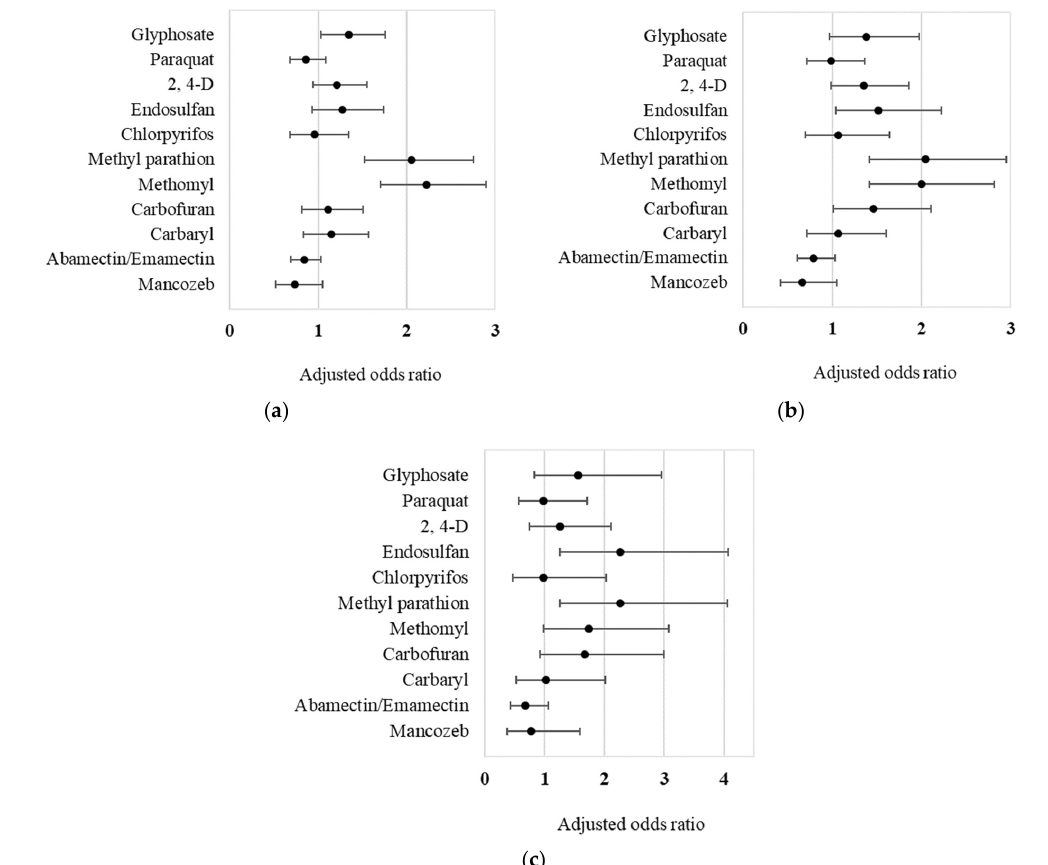
Figure 1. Testing multiple pesticide active ingredients with neurotic symptoms among farmers: ( a ) At P90 (score ≥ 2); ( b ) At P95 (score ≥ 3); ( c ) At score ≥ 6 (probable mental disorder), adjusted for